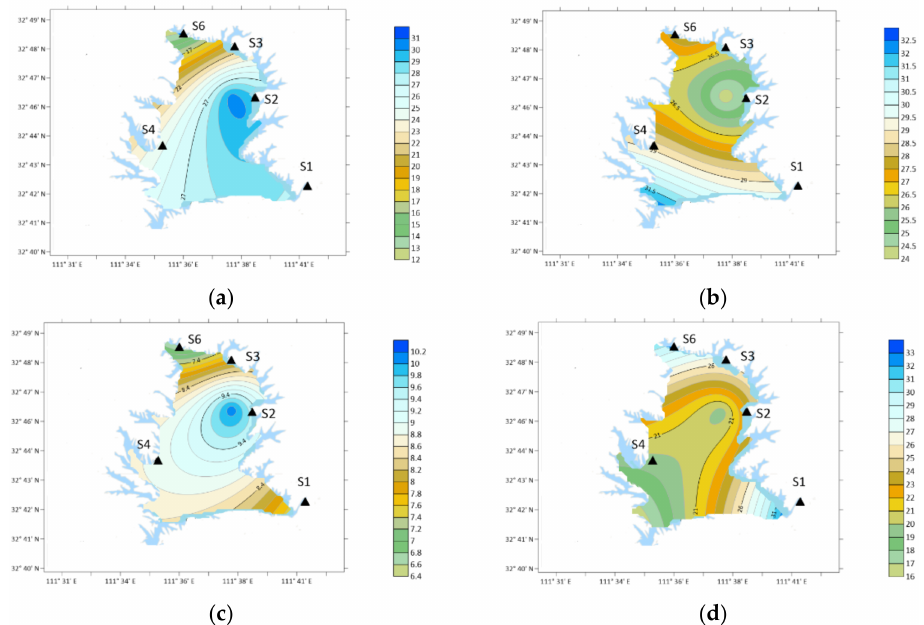
Figure 15. Spatial variation of 4-ELA concentration. ( a ) Winter; ( b ) spring; ( c ) summer; ( d ) autumn. Spatially, in winter: S2 > S1 > S6 > S3 > S4; Spring: S6 > S1 > S3 > S2 > S4; Summer: S2 > S6 > S4 > S1 > S3; Autumn: S1 > S4 > S3 > S2 > S6. The concentration of 4-ELA was the highest in S2 (Industrial Zone) in the southwest in winter and summer. In spring, the concentration was the highest at S6 (Forest Area). In autumn, the concentration was the highest at S1 (Urban